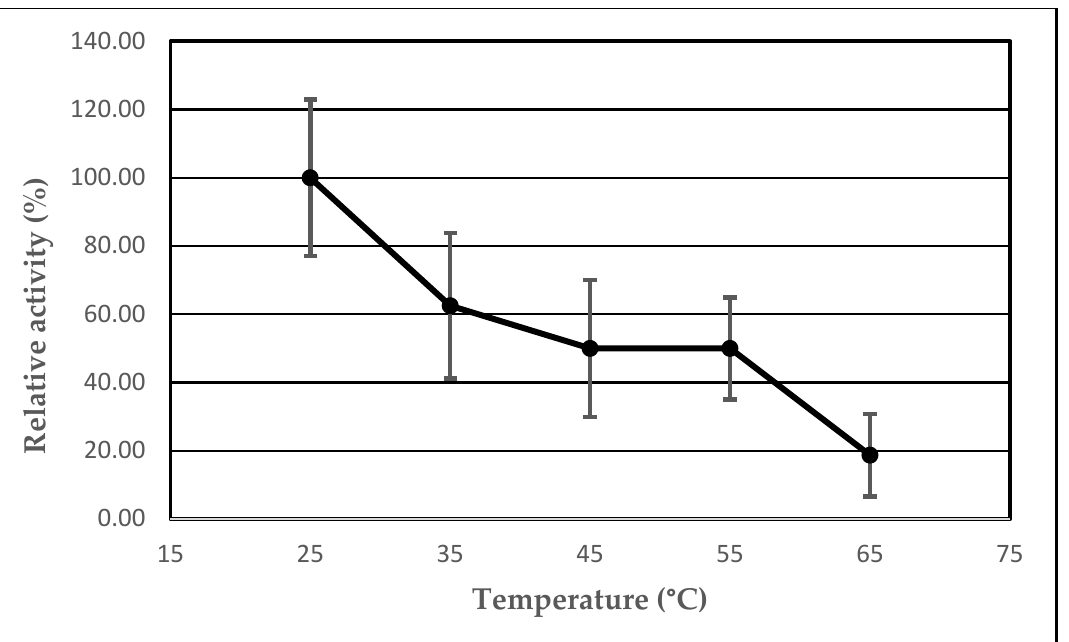
Figure 4. Effect of immobilization on AA-ANL activity under various thermal conditions. Reaction mixture: free AA-ANL (5.0 ± 0.2 mg) or AA-ANL immobilized on IB-150A beads, phosphate buffer (100 mM, pH 7.4), and an emulsion containing equal volumes of peanut oil and gum arabic suspension. The mixture was incubated for 30 min. The error bars represent the standard deviations of the mean.